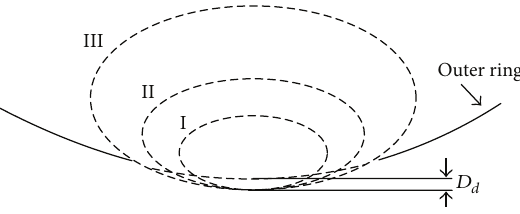
Figure 7: Outer ring: elliptical defect